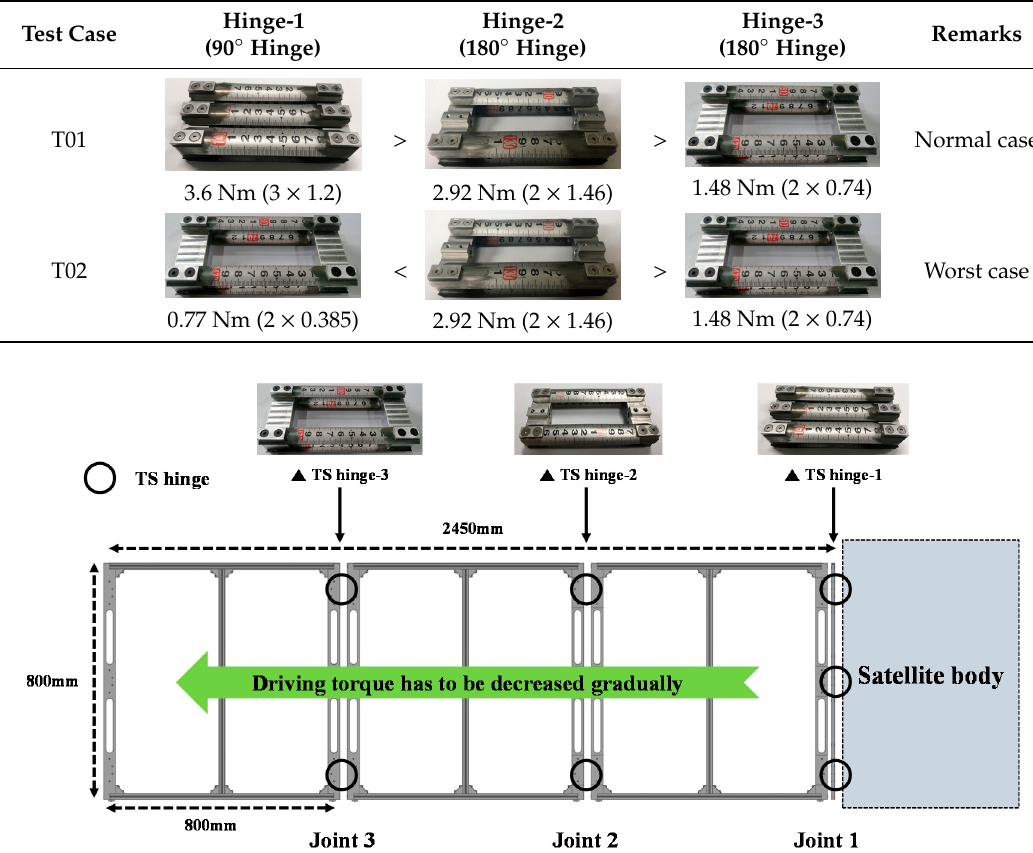
Table 2. TS hinges for three revolute joints for deployment test.